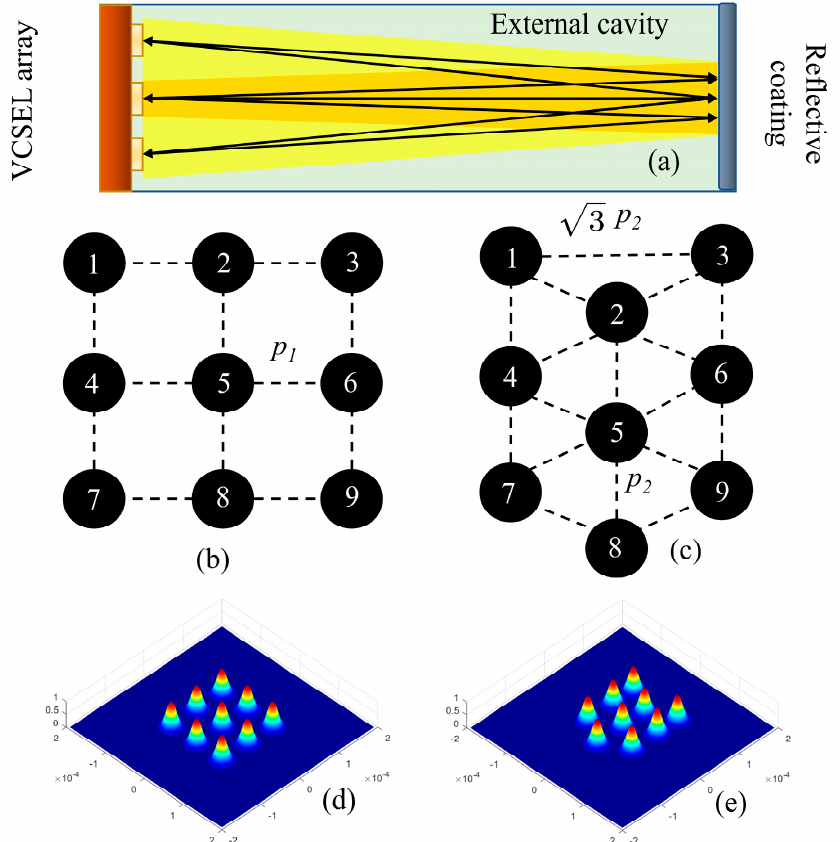
Figure 1. ( a ) Diagram of parallel-coupled external cavity VCSEL array; ( b ) position distribution of initial plane of square array; ( c ) position distribution of initial planar of regular hexagonal array; ( d ) initial planar amplitude distribution of the square array; ( e ) initial planar amplitude distribution of the regular hexagonal array.